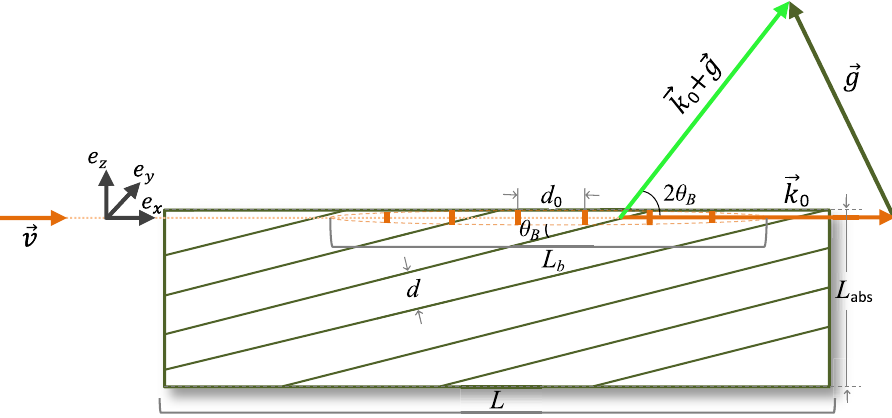
∼ 10 − 4 cm is the modulated bunch length, b